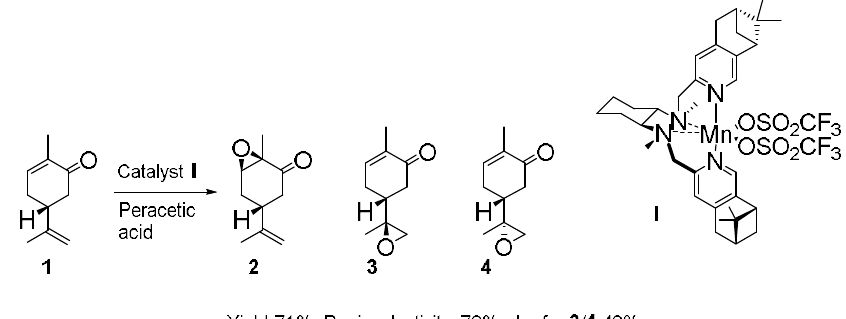
Scheme 1. Synthesis of the epoxides with 42 d.r.